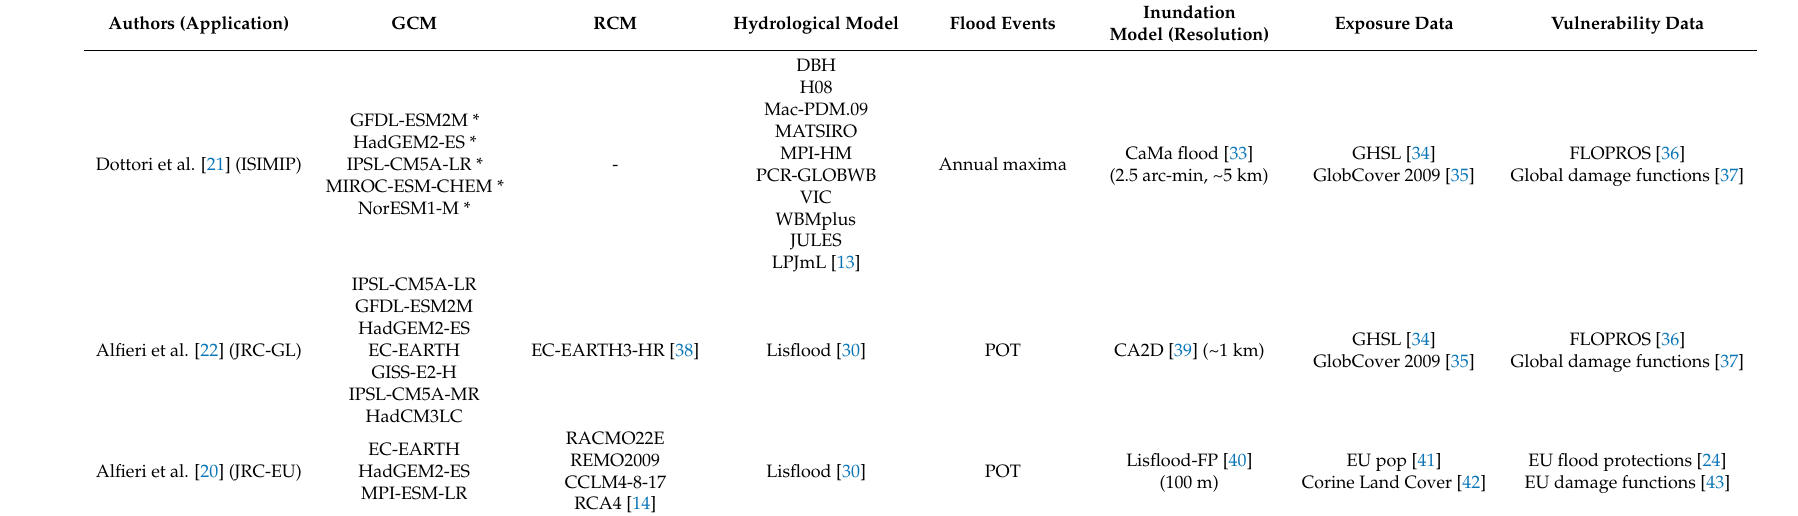
Table 1. Modeling components included in the three flood risk assessment studies and relevant